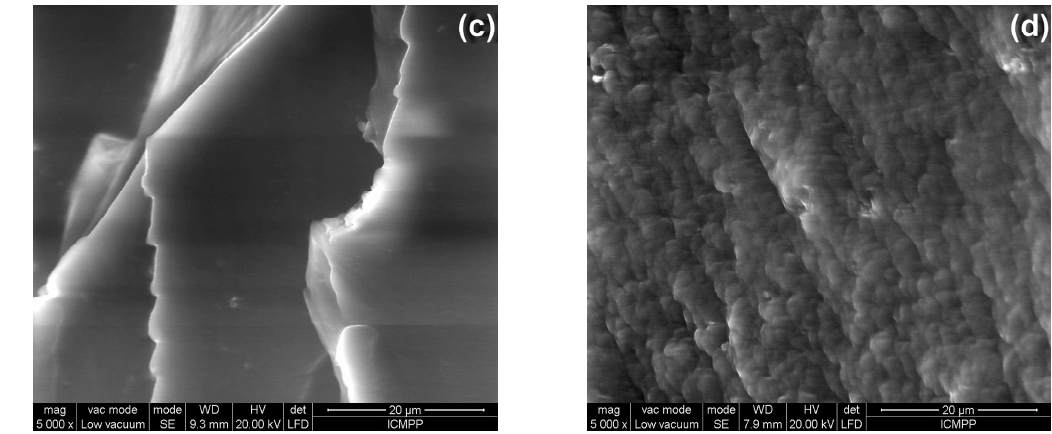
Figure 15. Micrographs of fractured surfaces of EPDM (M ( a )) and EPDM blends (E–B ( b ); E–Cl–B ( c ); E–Br–B ( d )) before irradiation (5000× magnification).